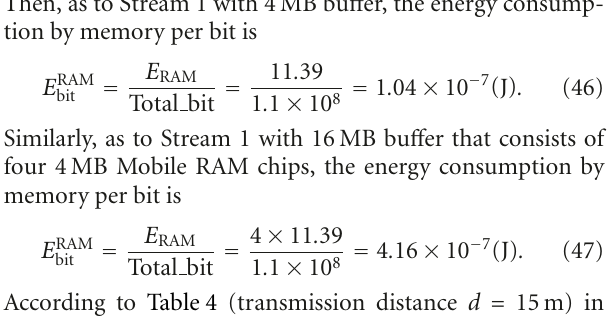
According to Table 4 (transmission distance d = 15 m) in P.15, the total energy of RF with 4 MB and 16 MB are 1 . 44 e − 6 and 0 . 10 e − 6, respectively. Then the total energy of RF and memory with 4 MB and 16 MB are 1 . 54 e − 6 and 0 . 52 e − 6, respectively. So our conclusion is still in e ff ect with the consideration of both RF and memory energy